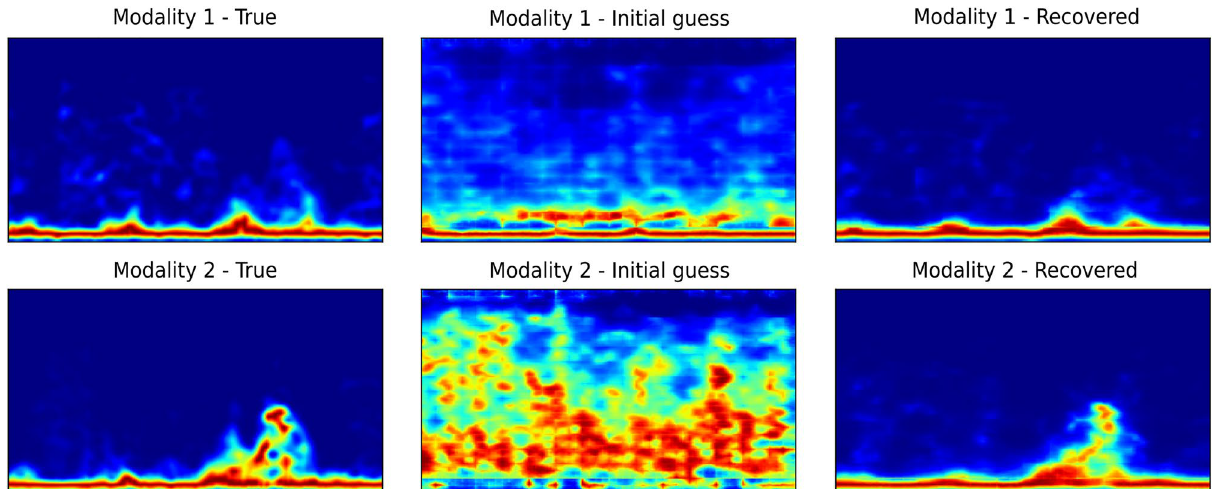
Figure 4. Illustration of spectrogram recovery (for sitting down activity) using compressed sensing with measurements as low as 784 out of 50,176 (1.56%). No additive white Gaussian noise is considered. The left column shows the true spectrogram sample, the middle column shows reconstruction with an initial guess (no optimization) while the right column shows reconstruction with ˆ z MAP .